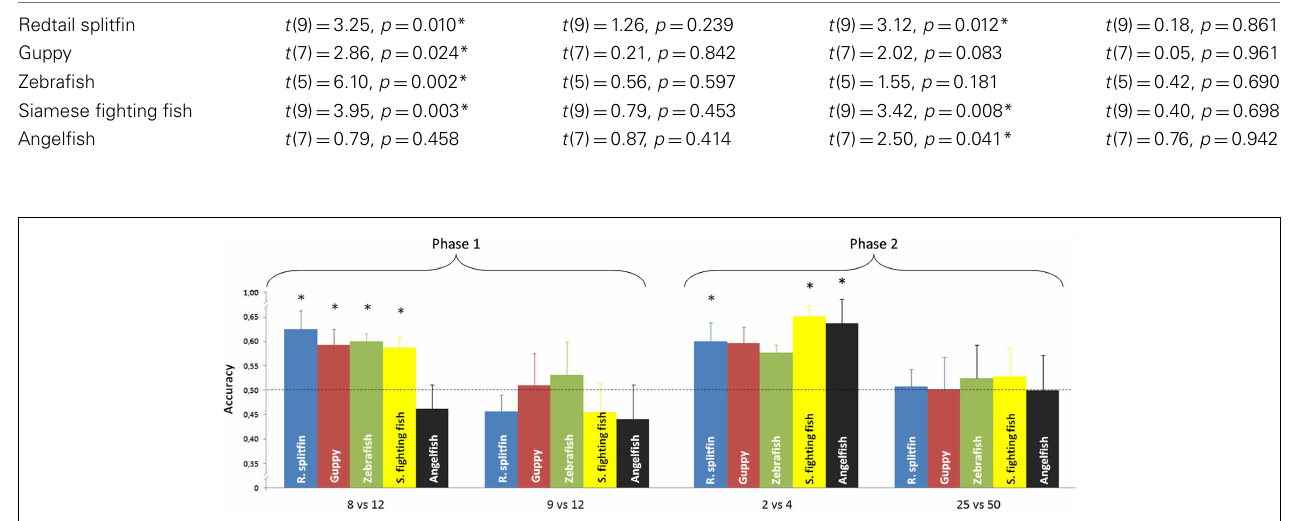
to discriminate 9 vs. 12 or generalize to larger numerosities (25 vs. 50). Asterisks denote a significant departure from chance level ( p < 0.05). Bars represent the standard